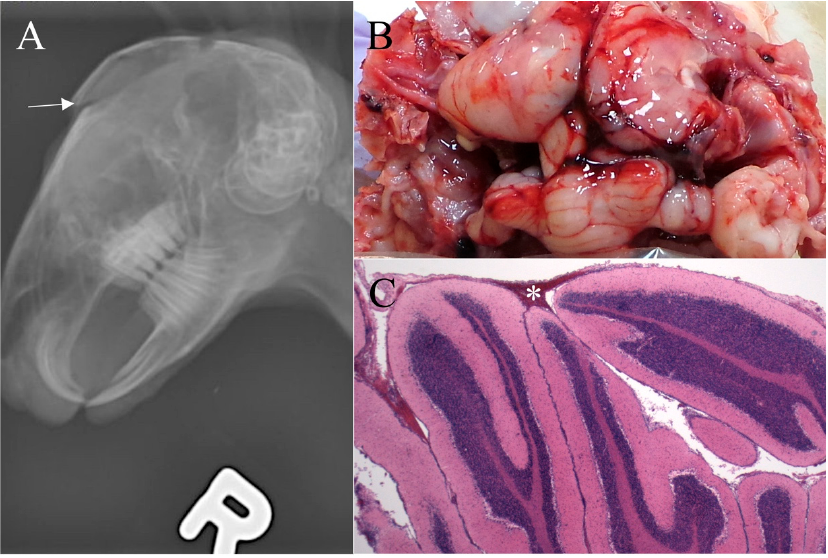
Figure 4. Six week-old grower rabbit euthanized by blunt force trauma. ( A ) Survey radiograph demonstrating fractured cranium (arrow); ( B ) Minimal subdural dorsal hemorrhage covers less than 25% of the brain surface (gross score of 1/4); ( C ) Photomicrograph of cerebellum (demonstrating mild subdural hemorrhage (*) (histologic score of 2/4) and no parenchymal hemorrhage (histologic score of 0/4). No subdural or parenchymal hemorrhage were noted in the midbrain. (H & E, ×20).